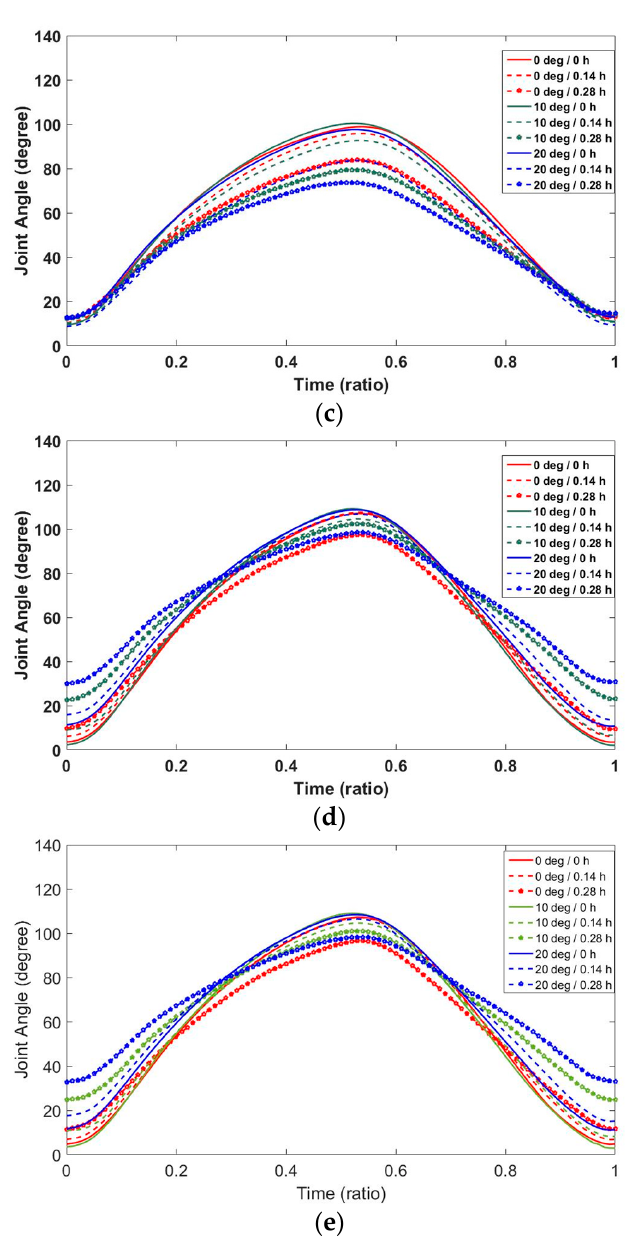
Figure 8. Flexion/extension of pelvis–thorax, hip, and knee joints for nine cases: flexions/extensions of ( a ) pelvis–thorax joint; ( b ) left hip joint; ( c ) right hip joint; ( d ) left knee; and ( e ) right knee.